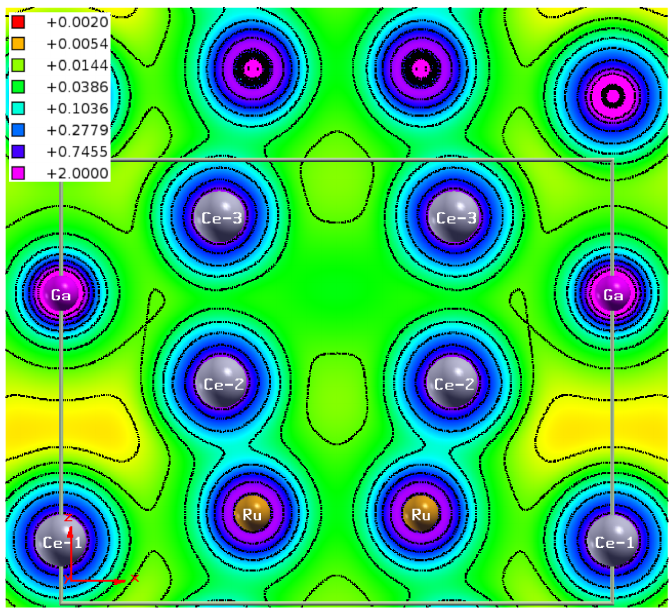
Figure 6. Electron densities ρ ( r ) / e (in (au) − 3 ) visualized for the crystallographic plane (010) of the crystal structure of Ce 9 Ru 4 Ga 5 . The projection of the unit cell is outlined by gray